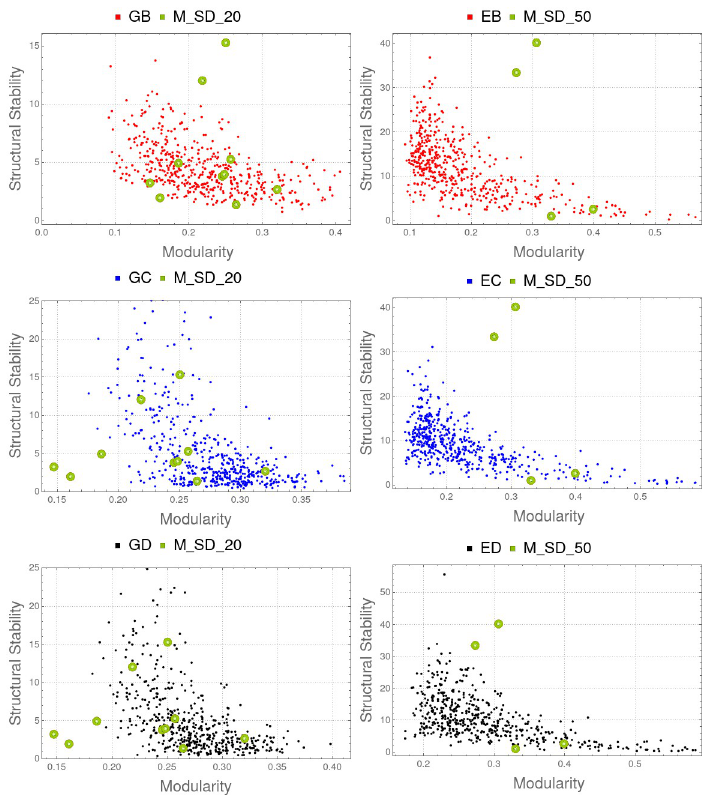
Fig 11. Optimal modularity and structural stability. Left (top to bottom): Comparison of M_SD_20 with GB , GC and GD . Right (top to bottom): Comparison of M_SD_50 with EB , EC and ED . Spearman correlation coefficient is lower than − 0.057 in all these cases except M_SD_20 (Table 2). It suggest that the formation of strongly interrelated communities within a biological system has a negative influence on maximal biological diversity.